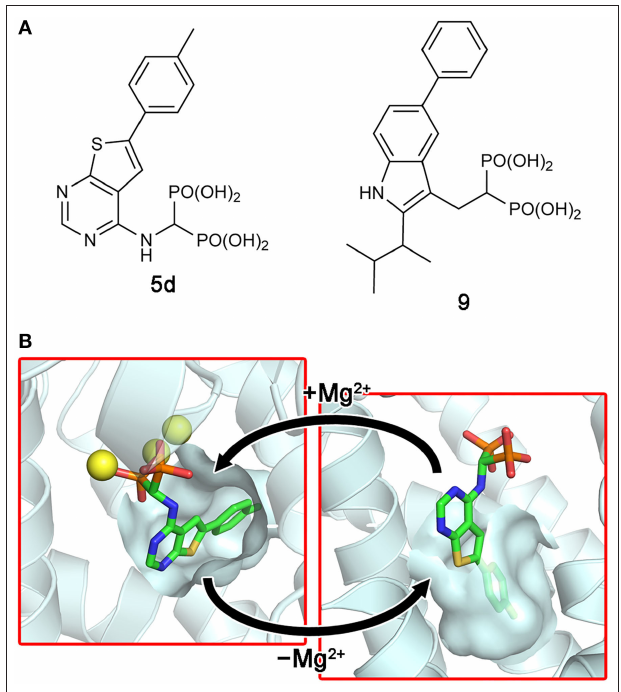
FIGURE 7 | Bisphosphonate inhibitors with a dual binding mode. (A) Examples of thienopyrimidine and benzimidazole bisphosphonates. (B) The binding of inhibitor 5d to the active site (left panel; PDB ID: 4JVJ) and the new druggable pocket (right; PDB ID: 4LPG) in the presence and absence of Mg 2 +